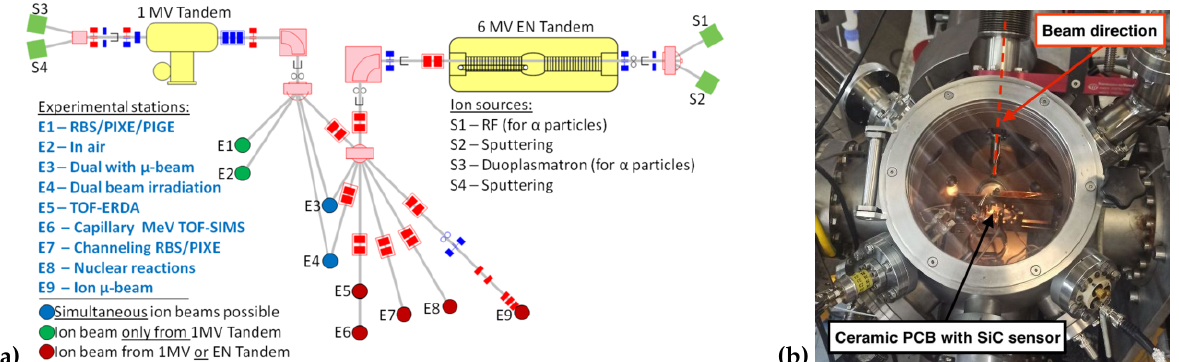
Figure 1. ( a ) Beamlines overview at the RBI accelerator facility [9]. THE 6.0 MV EN Tandem Van de Graaff and 1.0 MV HVE Tandetron are represented in yellow. The E9 experimental station corresponds to the Ion Microprobe. ( b ) The Ion Microprobe Chamber is shown, in which the beam is focused down to micrometer spot size, and in which the sample to be tested is placed (the photo shows the SiC membrane on the support